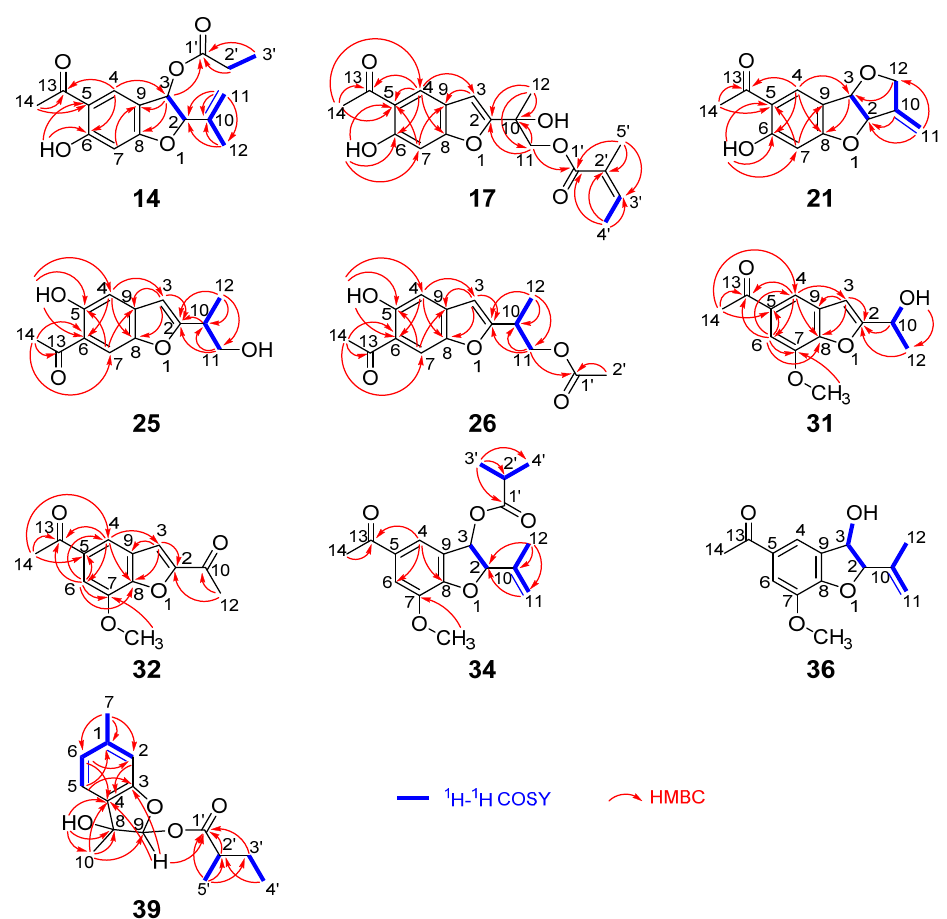
Figure 7. Key 1 H 1 H COSY and HMBC correlations for 10 new compounds.